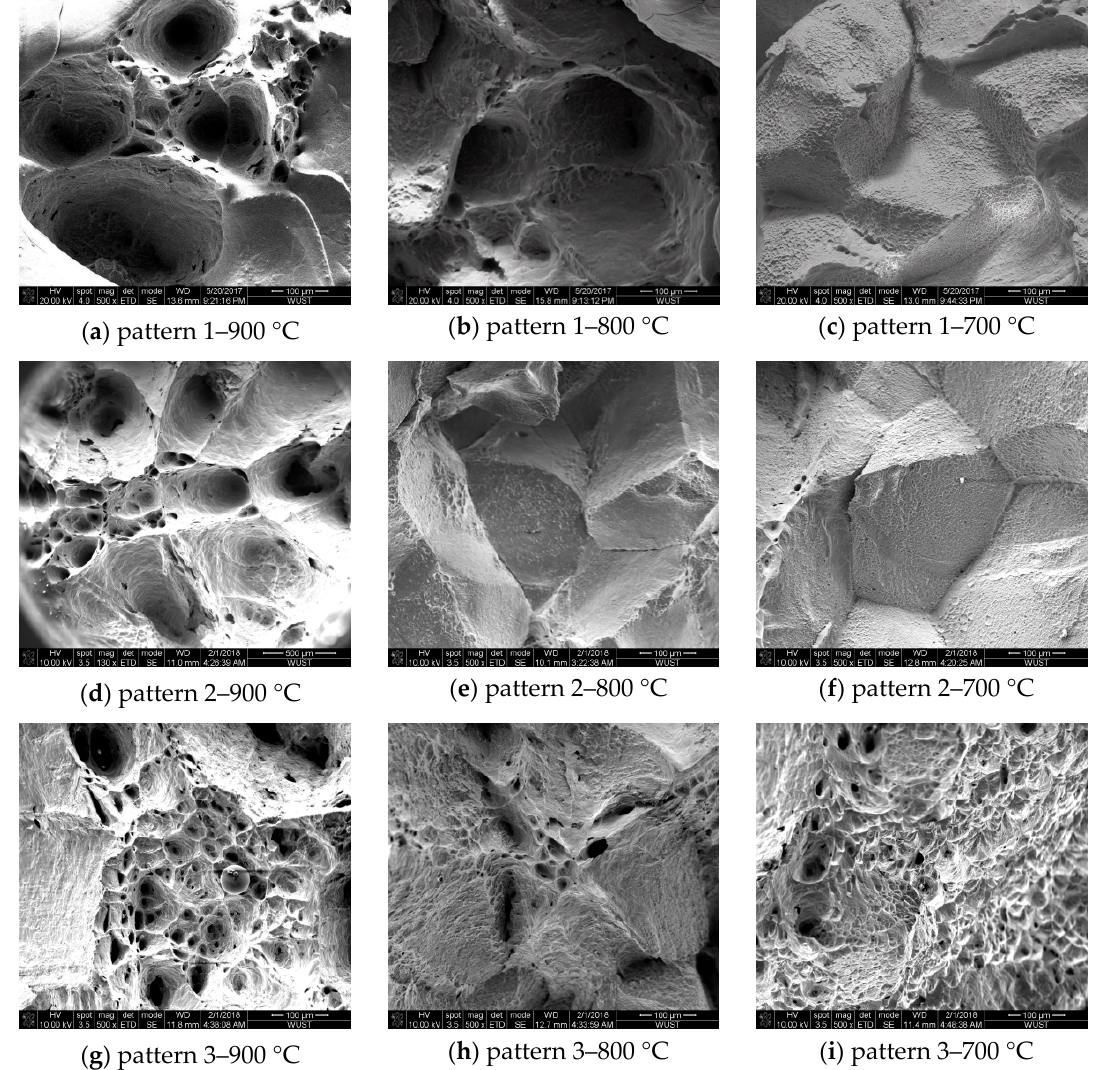
Figure 11. Tensile fracture morphology under different thermal schedules.